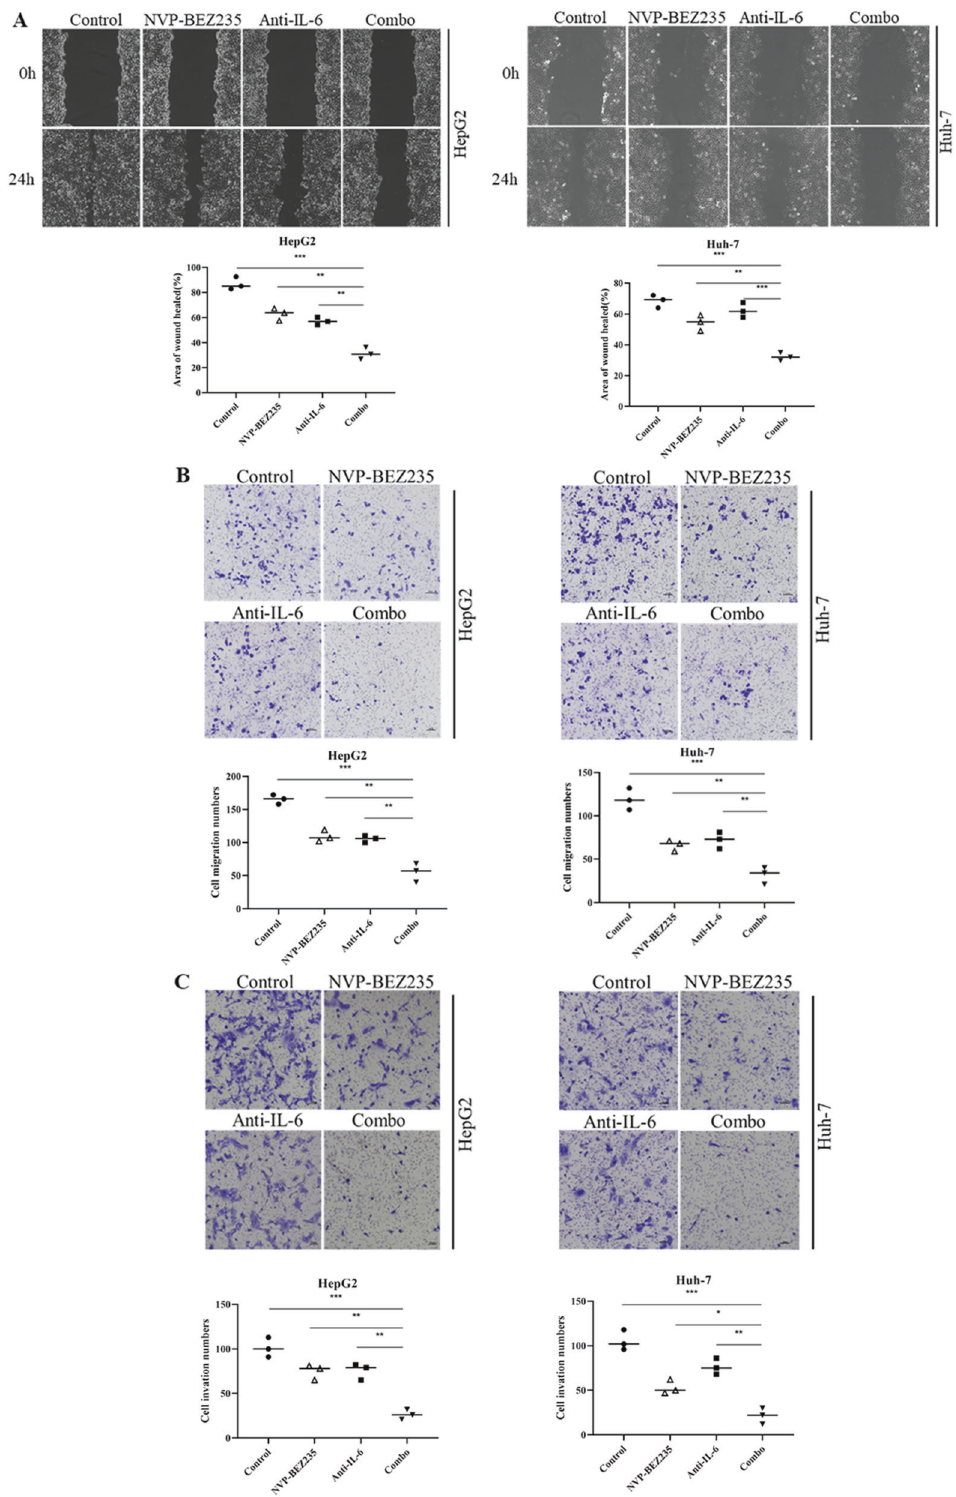
Fig. 5 IL-6 blockade increases NVP-BEZ235-induced inhibition of cell migration and invasion in HCC cells. A The scratch experiment in response to treatment of HepG2 and Huh-7 cells with NVP-BBEZ235, anti-IL-6 Ab, or their combination for 24 h. B Analysis of Transwell migration assay upon treatment of HepG2 and Huh-7 cells with NVP-BBEZ235, anti-IL-6 Ab, or their combination for 24 h. C Analysis of Transwell invasion assay upon treatment of HepG2 and Huh-7 cells with NVP-BBEZ235, anti-IL-6 Ab, or their combination for 24 h.